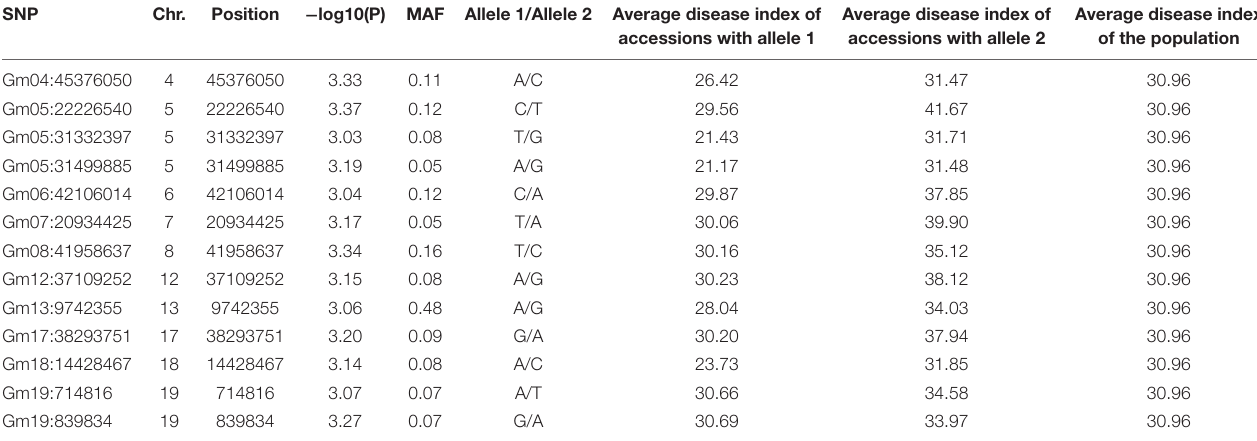
TABLE 2 | Peak SNPs and beneficial alleles associated with FLS race 1 resistance identified by GWAS. SNP Chr.